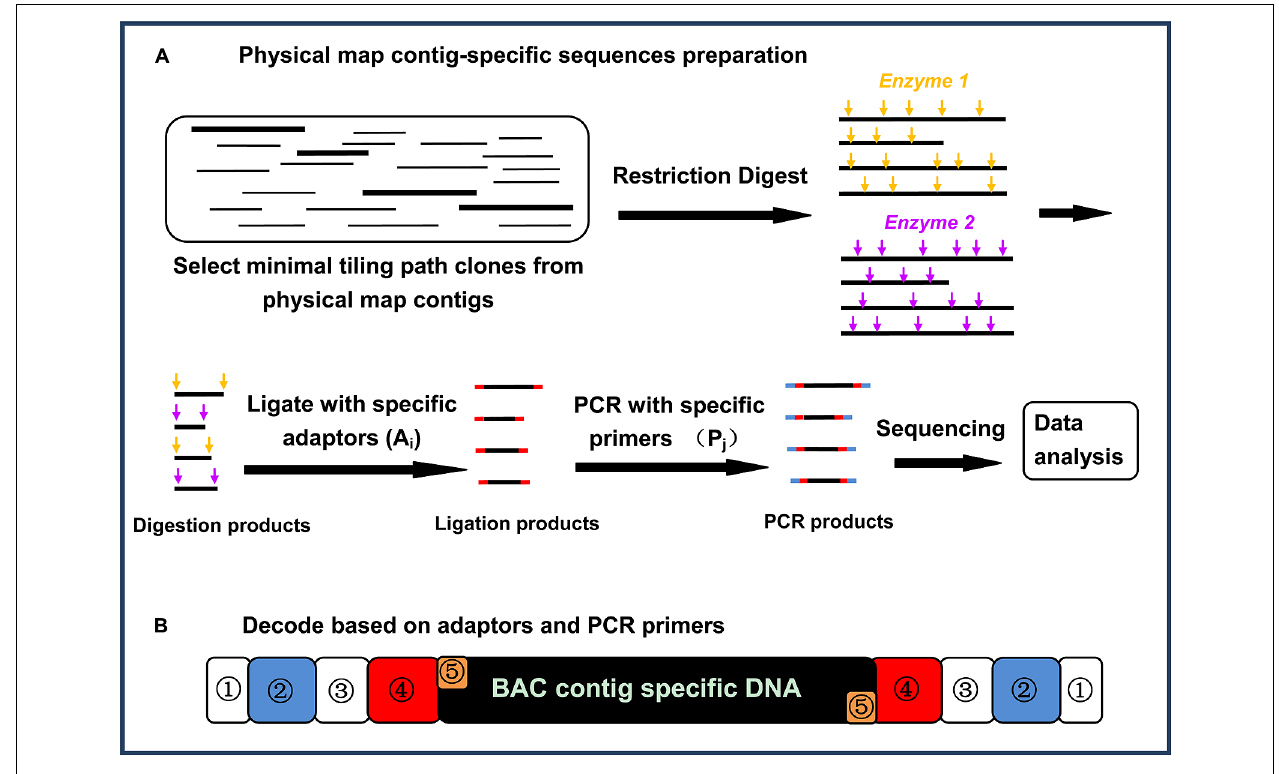
primers. Each PCR product was attached to a physical map contig-specific tag at both ends. The tag representing the physical map contig ID contains five parts: j represents the shields DNA, k represents the specific barcoded sequencing in the primer (Pj), l represents the common/complementary sequences between the adaptor and the PCR primer, m represents the specific barcoded sequences in the adaptor (Ai), and n represents the overhangs proximal to the fragments for ligation (Jiang etal.,